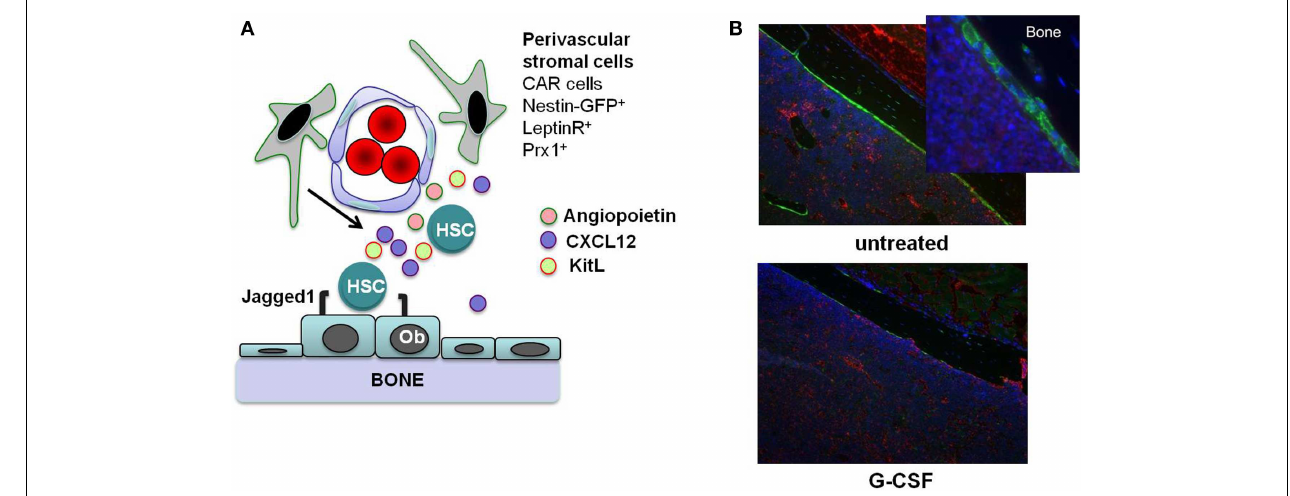
and Jagged1. (B) G-CSF treatment alters the HSC niches. Shown are sections from the femurs of Col2.3-GFP mice with osteoblast-specific GFP expression. After 7days of G-CSF treatment (125 µ g/kg given subcutaneously twice a day; bottom panel), there is a marked loss of osteoblasts (green color) compared to an untreated control animal (top panels). Original magnification 10 × . Photo courtesy of Adam